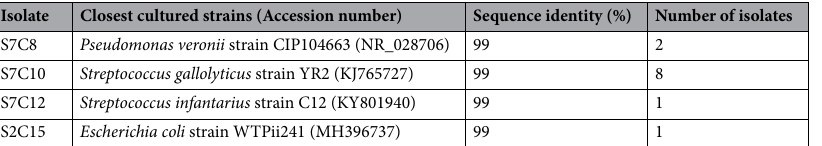
Isolate Closest cultured strains (Accession number) Sequence identity (%) Number of isolates